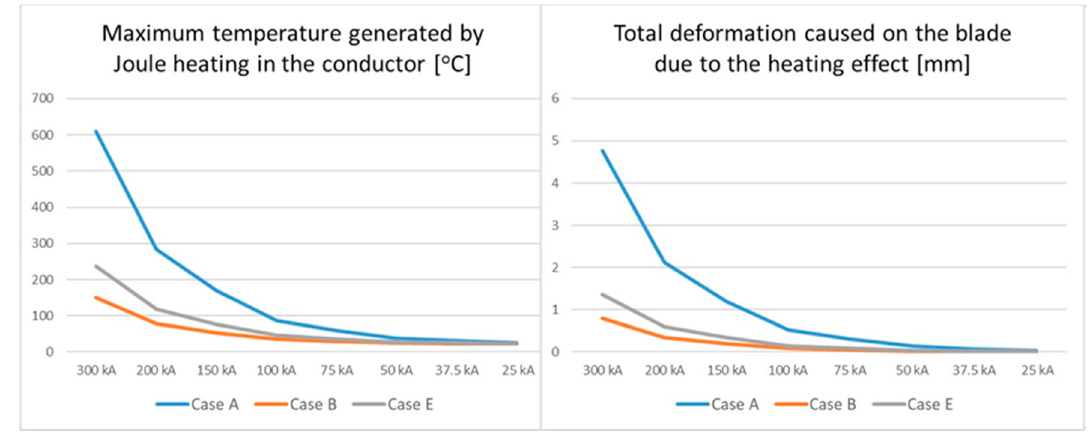
Figure 9. Maximum temperature ( left ) and total deformation ( right ) of the blade at A, B, and E case studies.